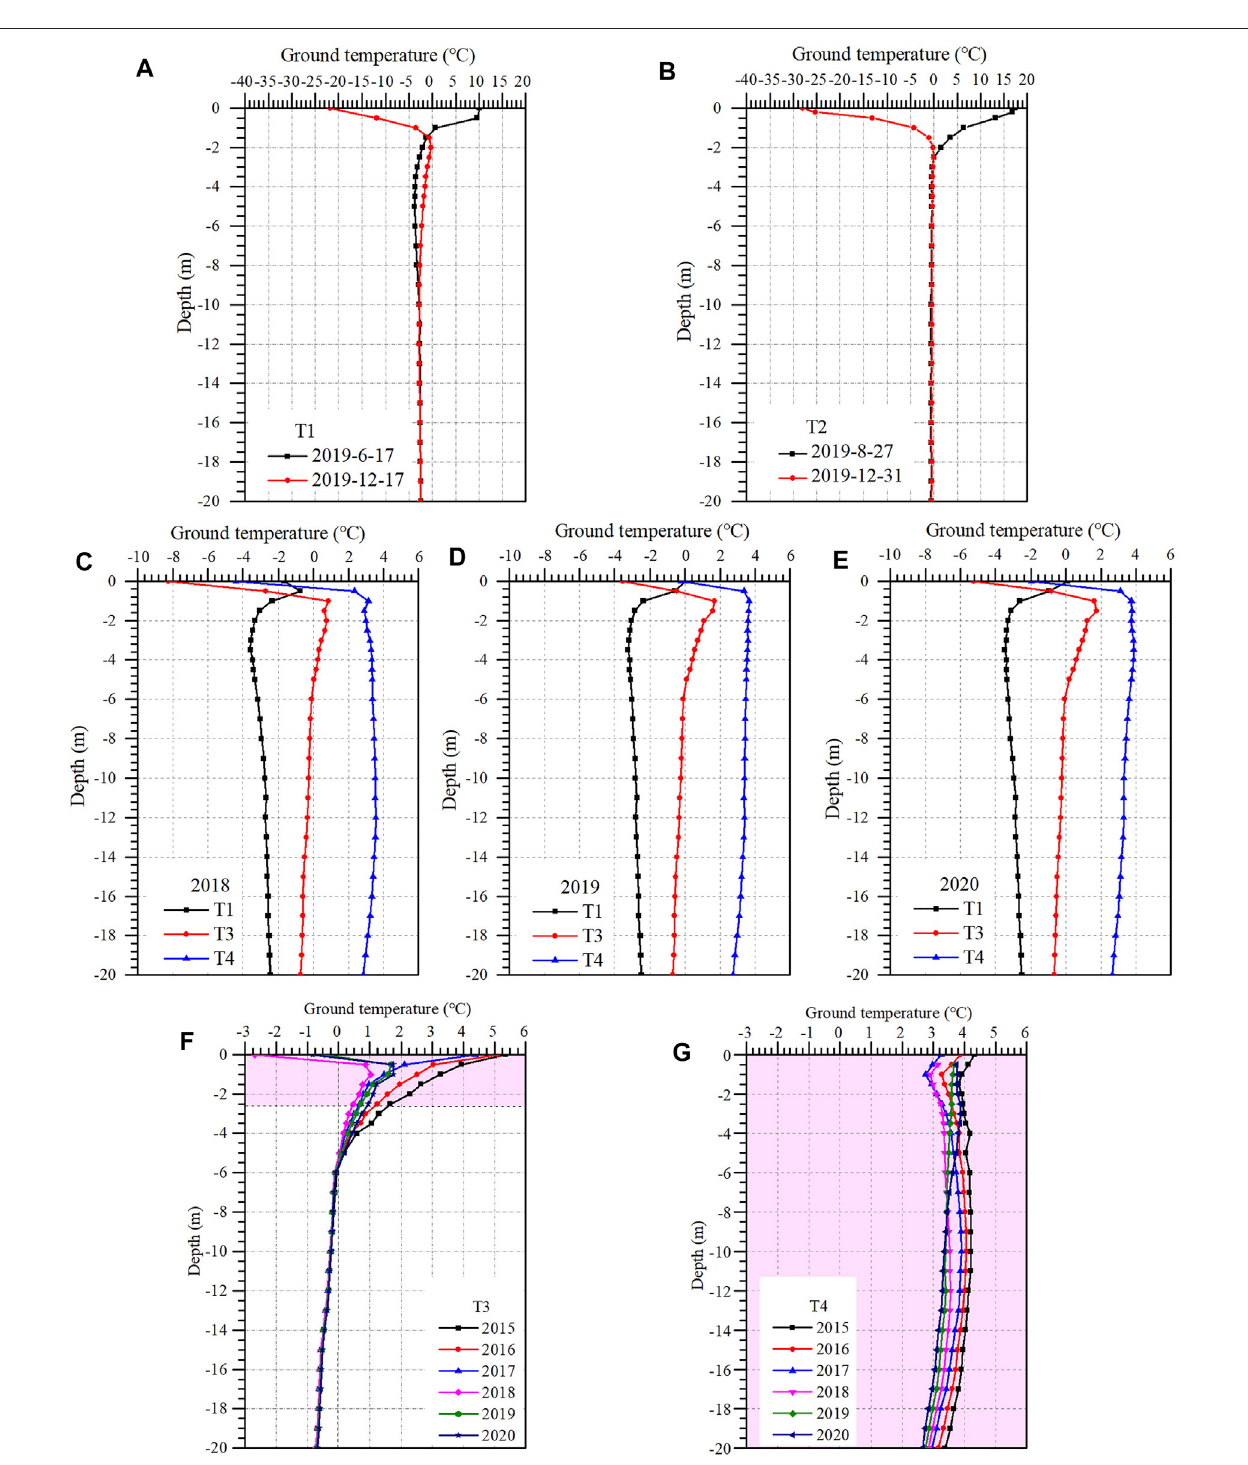
FIGURE 3| Ground temperatures in the Gulianhe strip coalmine in the Hola Basin in the northern Da Xing ’ anling Mountains, Northeast China. Notes: (A,B) ground temperature – depth pro fi les in Boreholes T1 and T2 in the undisturbed area, respectively, in 2019; (C – E) mean annual temperatures of soil at all measured depths in BoreholesT1(undisturbedarea),T3(2.6 mback fi ll),andT4(20 mback fi ll),respectively,from2018to2020;and (F,G) measuredmeanannualsoiltemperatureatdepths of 0 – 20 m in Boreholes T3 and T4 in the back fi lled area, respectively, in 2015 – 2020. The rectangles in purple represent the depth of the back fi lled layer.